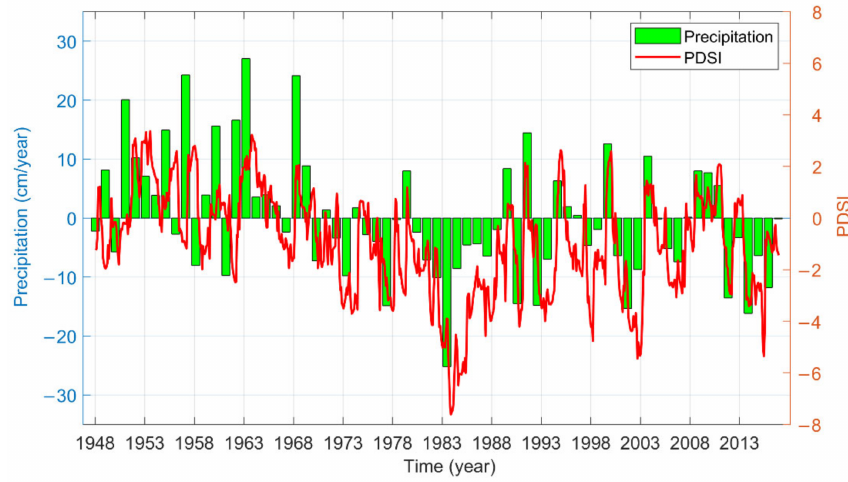
Figure 3. Annual precipitation anomalies relative to mean precipitation of 1948 − 2016 and PDSI time-series.